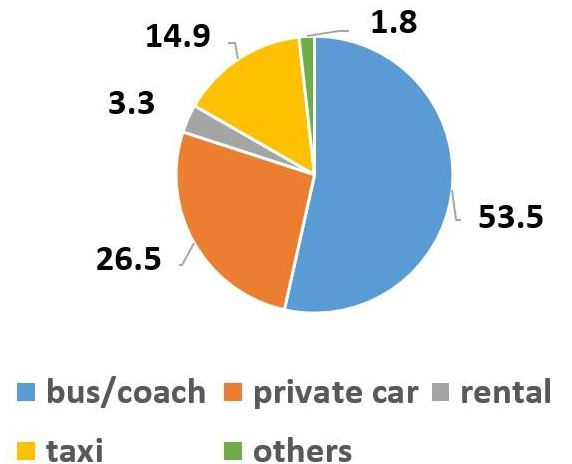
Figure 4. Share (percentage of total passengers) of the means of transportation used by passengers to/from the airport.